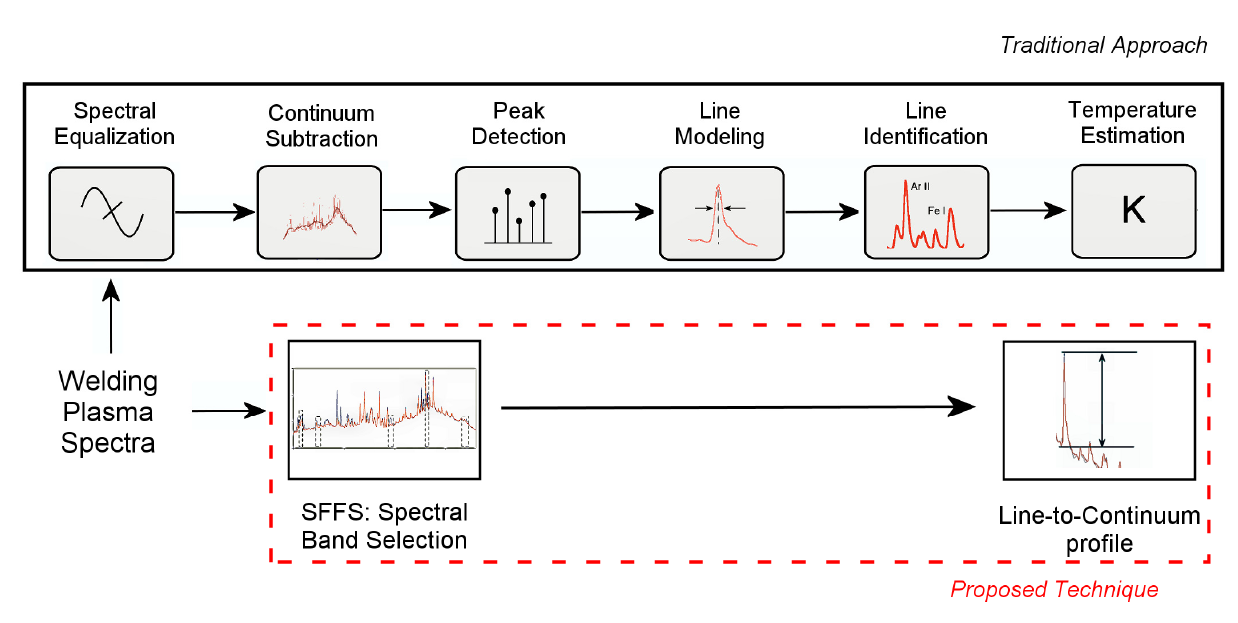
Figure 1. Comparison of the processing schemes associated with the traditional approach and the proposed solution based on SFFS and the line-to-continuum